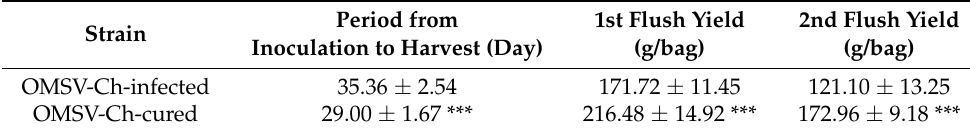
Table 1. Effects of the OMSV infection on the P. ostreatus measured in the cultivation test.